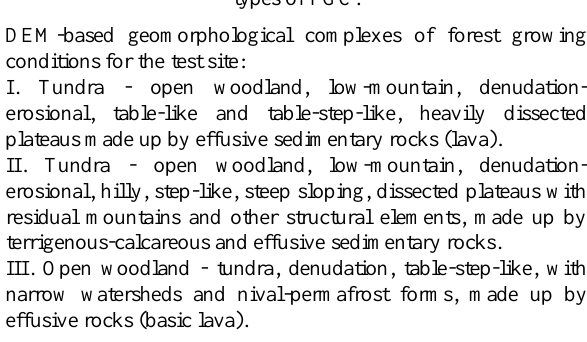
Figure 4. Two layers composite map of potential forest growing conditions for two hierarchical classification levels: GMC and types of